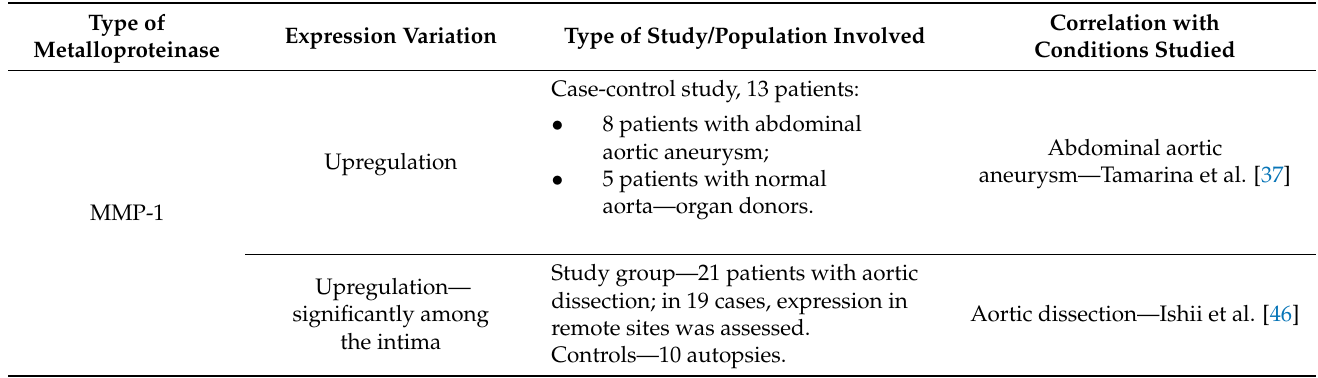
Table 1. Summary of literature data sustaining biomarker role of tissular MMP-1, MMP-2, MMP-9, TIMP-1 and TIMP-2 among several aortic-related